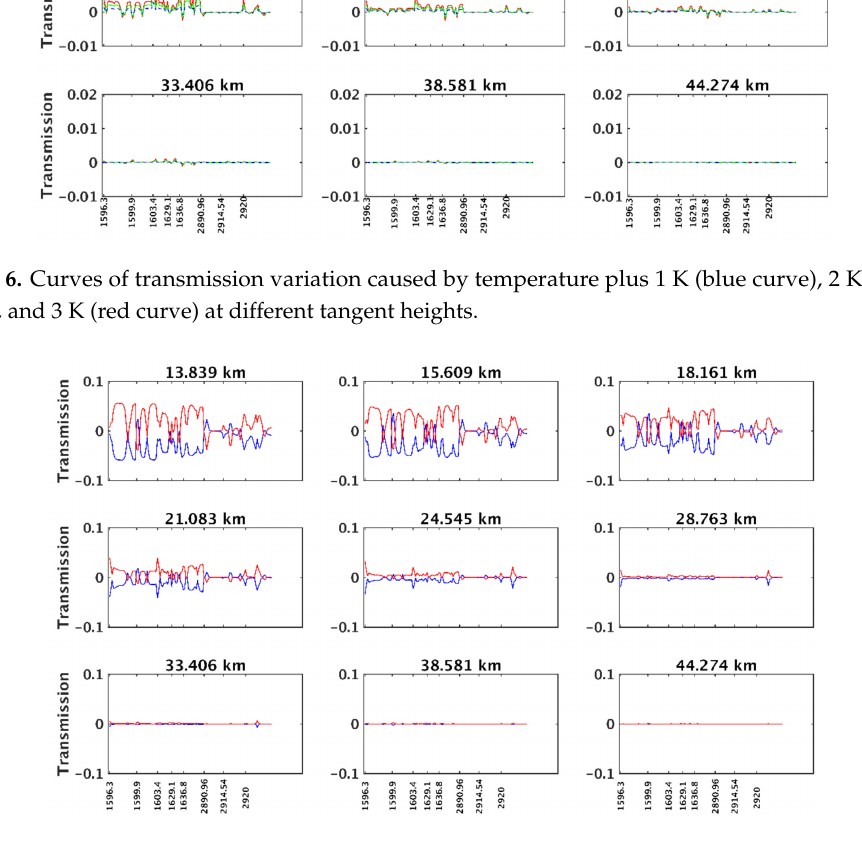
Figure 7. Curves of transmission variation caused by tangent height plus 500 m (red curve) and minus 500 m (blue curve) at different tangent